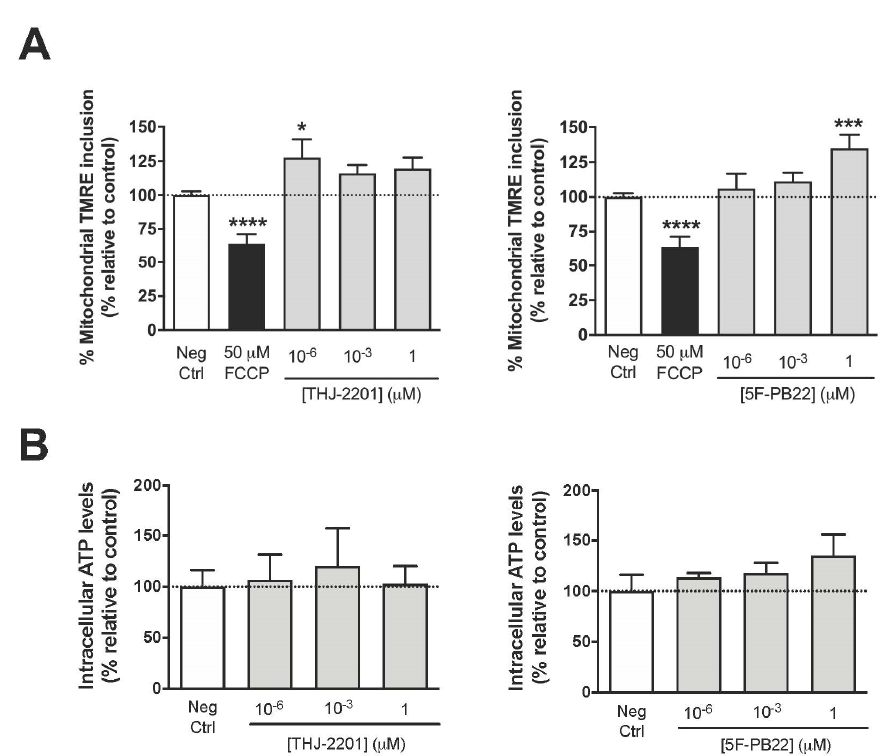
Figure 2. Assessment of mitochondrial parameters following NG108-15 cell exposure to 5F-PB22 and THJ-2201. NG108-15 cells were incubated for 24 h with the SCs at concentrations ranging from 1 pM to 1 µ M. ( A ) Mitochondrial membrane potential, assessed through TMRE accumulation. 50 µ M FCCP was used as positive control; ( B ) Intracellular ATP levels, measured using a luciferin-luciferase-based assay. Each bar represents the mean ± SEM, for at least six independent experiments, performed in duplicate. Results were normalized by the total amount of protein and expressed as the percentage relatively to the negative control (0.1% DMSO). * p < 0.05, *** p < 0.001, **** p < 0.0001, compared to the negative (vehicle-treated) control (one-way ANOVA, followed by Dunnett’s